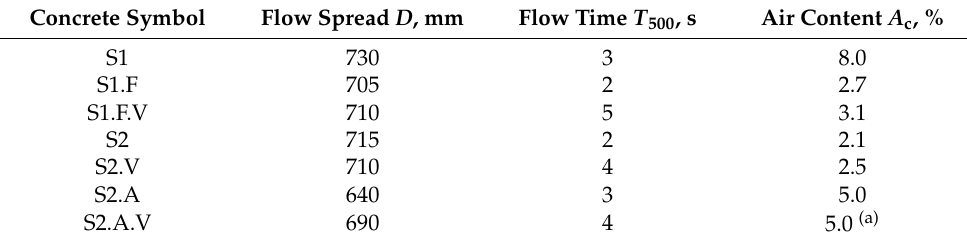
Table 4. Consistency and air content in concrete mixes modified with admixtures [26,27]. Concrete